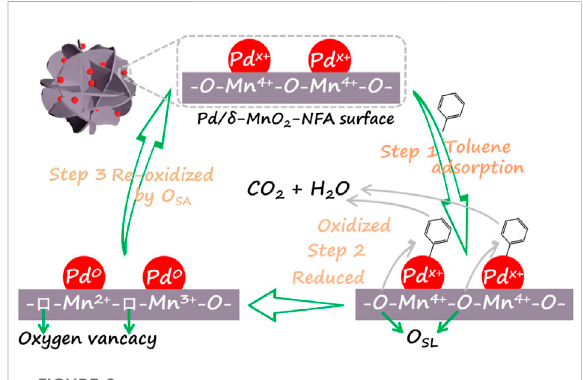
FIGURE 8 Possible reaction mechanism for toluene oxidation over 0.05Pd/ δ -MnO 2 -NFA